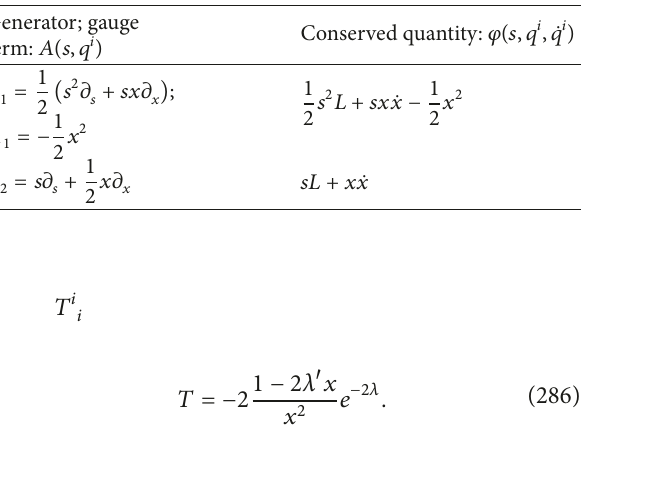
Table 43: Conserved quantities corresponding to each Noether